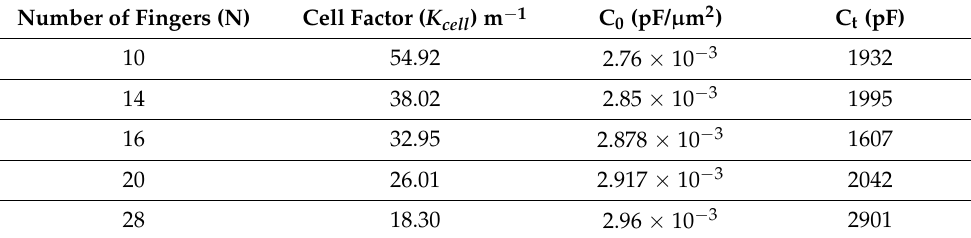
Table 2. Comparison of effect of number of fingers in comb electrode (n) on total interface capacitance C t (with L = 1.4 mm, W = 0.2 mm for 10 and 14 fingers and L = 1.4 mm, W = 0.1 mm and 16, 20, and 28 fingers, respectively).